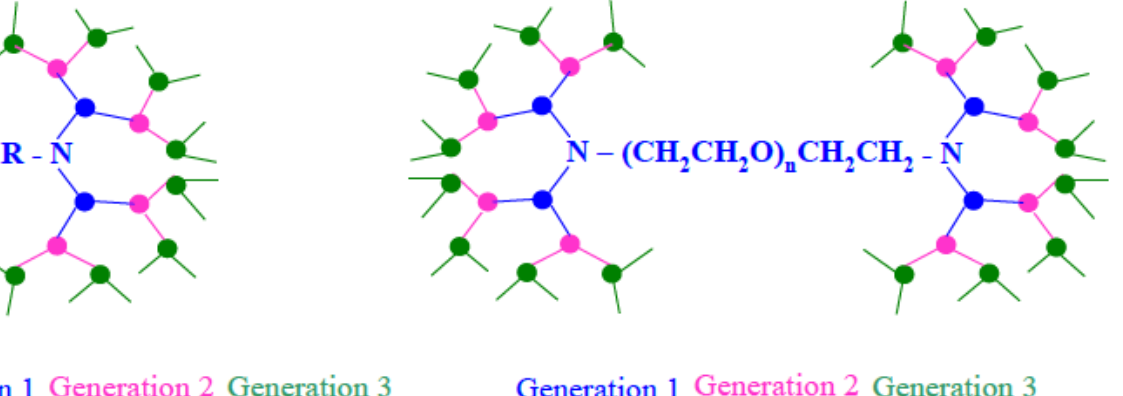
Figure 2. Formation of a 3rd generation dendrimer from a mono-amino initiator, each dot represents an asymmetrical AB 2 amino acid molecule. ( Left ): R is the initiator and can be a small molecule resulting in a compact spherical dendrimer or a water-soluble biocompatibilizing polymer, e.g., PEG, yielding a PEG-anchored dendrimer. ( Right ): a dumbbell shaped dendrimer forms from a bifunctional polymeric initiator.